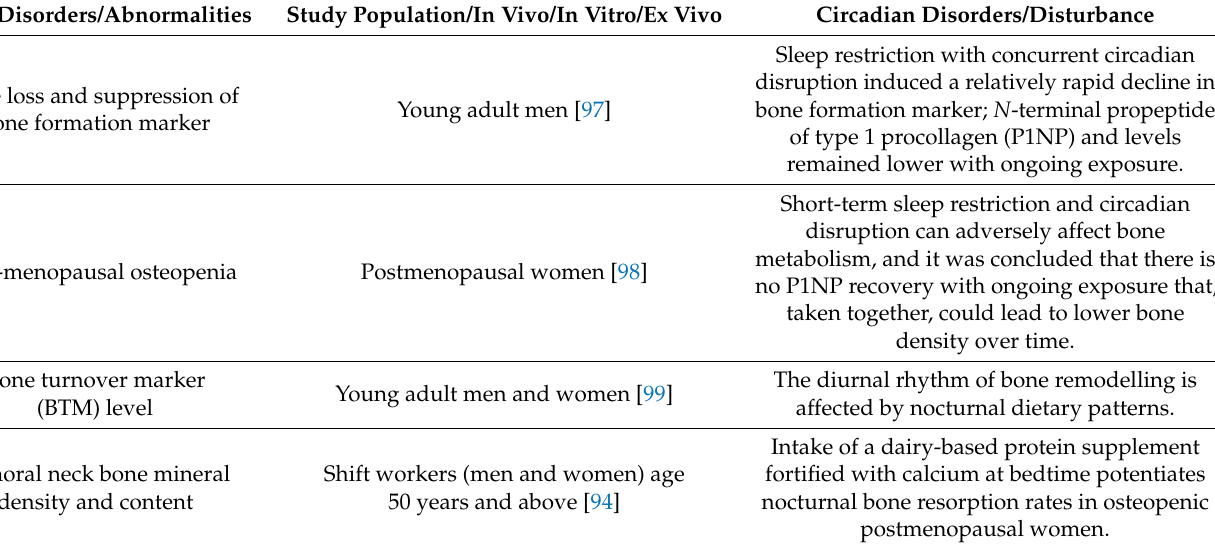
Table 1. In vitro, in vivo, and ex vivo works depict that circadian rhythm regulates bone metabolism and bone disease. Circadian rhythm is well known to affect bone metabolism and bone disease. However, its molecular mechanism is still not well understood. The table above shows some of the findings on the molecular mechanism involving circadian rhythm and bone